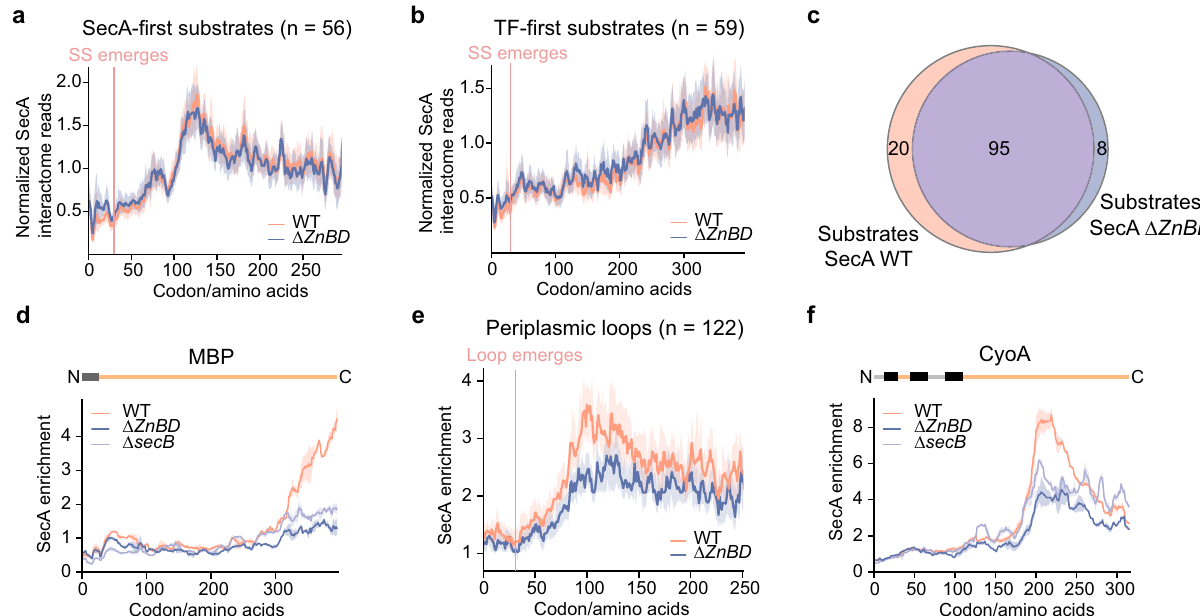
Fig. 5 Impact of SecB on cotranslational SecA interactions. a , b Metagene SecA interactome pro fi le of SecA- fi rst ( a ) and TF- fi rst ( b ) substrates aligned to the N-terminus of signal sequences. Solid lines show the mean values, and shaded areas show the 95% CI. c Venn diagrams showing the overlap of nascent secretory substrates of SecA and SecA Δ ZnBD. d , f Representative SecA interaction pro fi les of a secretory protein ( d ) and an IMP ( f ) on which SecA binding is compromised. Protein topology is shown above and colored as in Figs. 2b and 4c. Solid lines show the mean values, and shaded areas show the range of data from two independent biological replicates. e Metagene SecA enrichment of large periplasmic loops aligned to their N-terminus. The median values of SecA enrichment in WT strain and in Δ ZnBD strain are compared. Shaded areas show the 95%